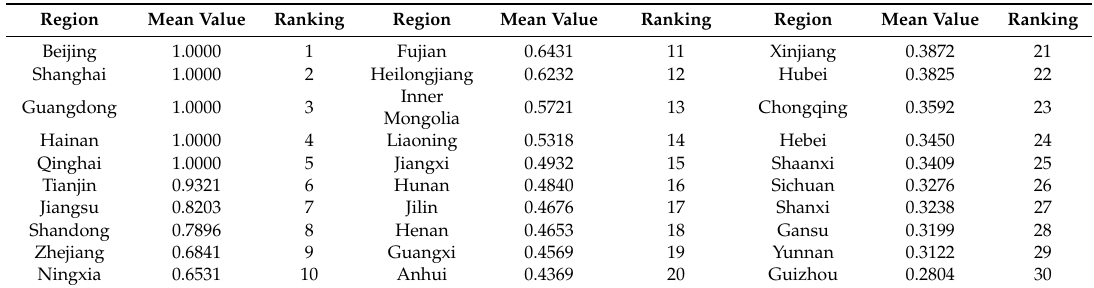
Figure 2. Change trend of China’s regional green development efficiency in 1997–2017. Table 1. Average e ffi ciency of green development in China’s provinces in